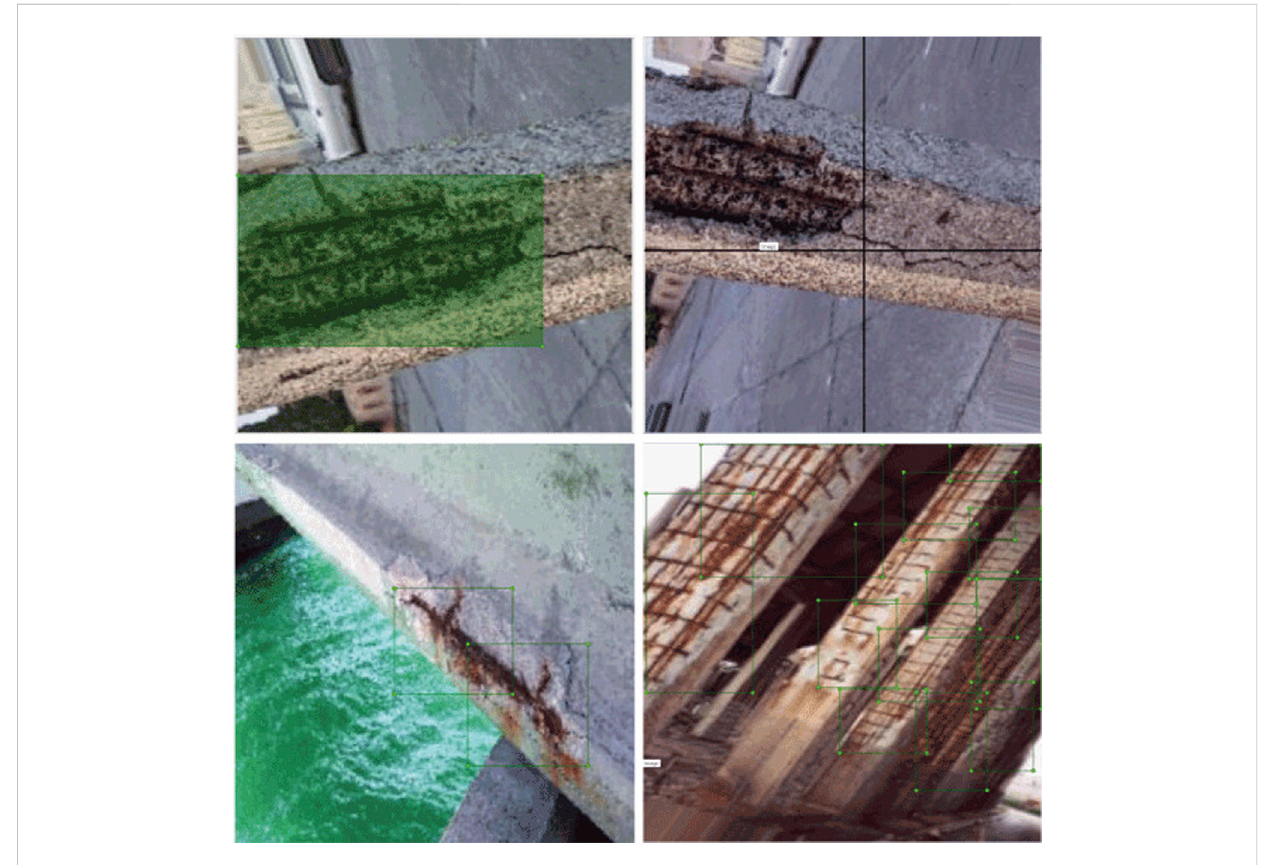
FIGURE 7 Labeling process of some representative